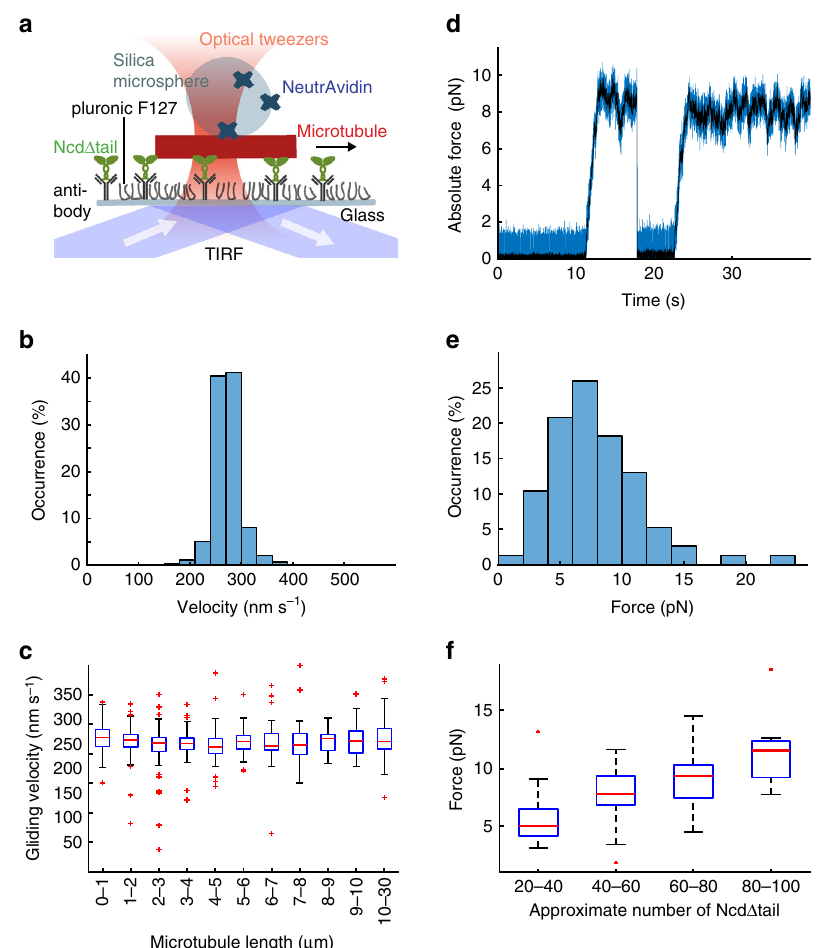
Fig. 1 Statically anchored kinesin-14 motors exert pN-range forces. a Truncated, SNAP f -tagged Ncd (Ncd Δ tail) motors were surface immobilized by anti- SNAP-antibodies. The surface was passivated using the polymer pluronic F127. Biotinylated microtubules interacted with Ncd Δ tail motors (gliding geometry) and with silica microspheres that were manipulated by optical tweezers. b Velocity distribution of all gliding microtubules ( N = 867). c Microtubule gliding velocities without external load were constant over a wide range of microtubule lengths, corresponding to a wide range of Ncd Δ tail motor numbers. The values represent averaged velocity values per microtubule, which were afterwards time weighted (this data treatment was chosen for better comparison to Fig. 2c). The number of microtubules per depicted bin is shown in Supplementary Figure 1 and ranges from 25 to 124 microtubules. For the boxplot elements description see Methods. d Characteristic force trace for a microsphere attached to a microtubule that was transported out of the center of the optical tweezers until the stopping force was reached. After that the bead detached and rebound to the same microtubule and was again transported until the stopping force was reached. The stopping force was calculated by averaging over the time period when the microtubule was stopped (see Methods). Note that absolute force is plotted here (see Methods). e Distribution of forces exerted on gliding microtubules by teams of Ncd Δ tail immobilized to a glass surface ( N = 78). f Microtubule stopping force, binned according to the approximate number of Ncd Δ tail motors. The motor number was calculated from the microtubule length and the motor density on the surface, which was quanti fi ed by fl uorescence intensity (see